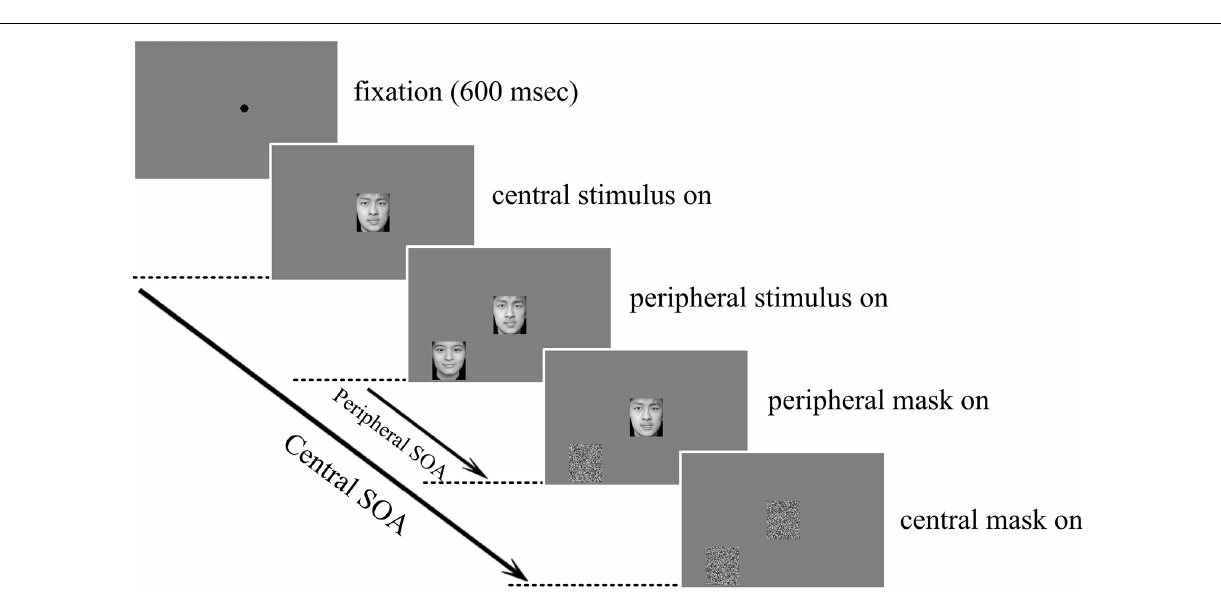
FIGURE 2 | Central – peripheral emotional faces discrimination experimental protocol. Subjects were required to fixate at and focus attention on the central task and to respond whether the emotion was positive or negative for both the centrally and peripherally presented faces. Both the central and peripheral faces were masked individually after the corresponding